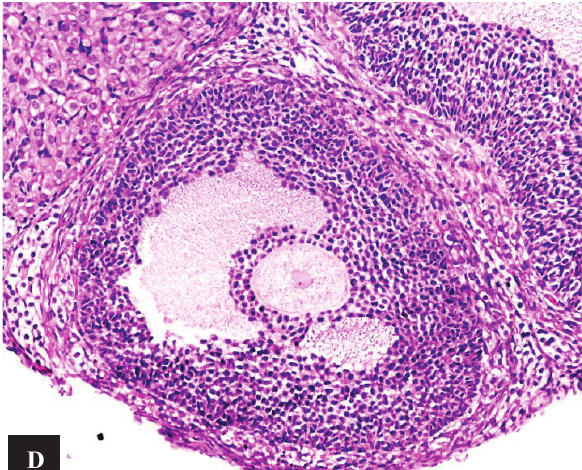
Fig-2D: Secondary follicle of rat experimental group D showing normal structure (H&E,